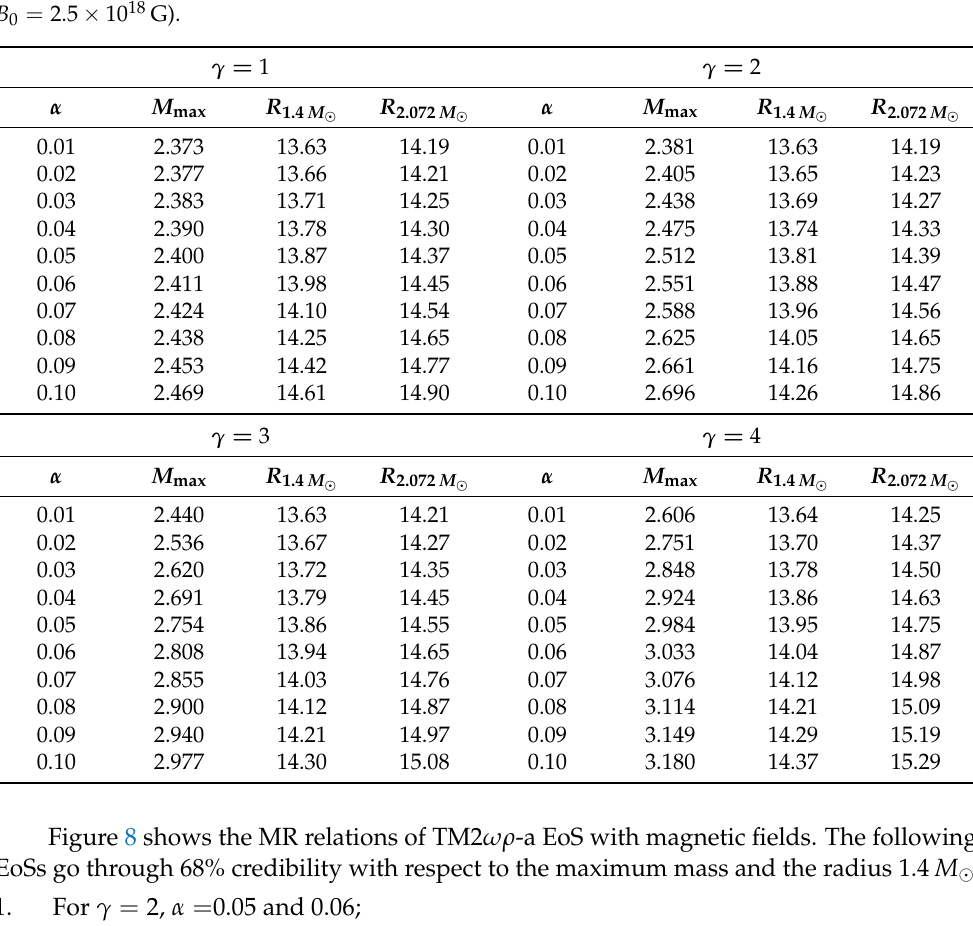
) for NL3 ωρ -b EoS with magnetic fields ( B s = 10 12 G, (cid:12)